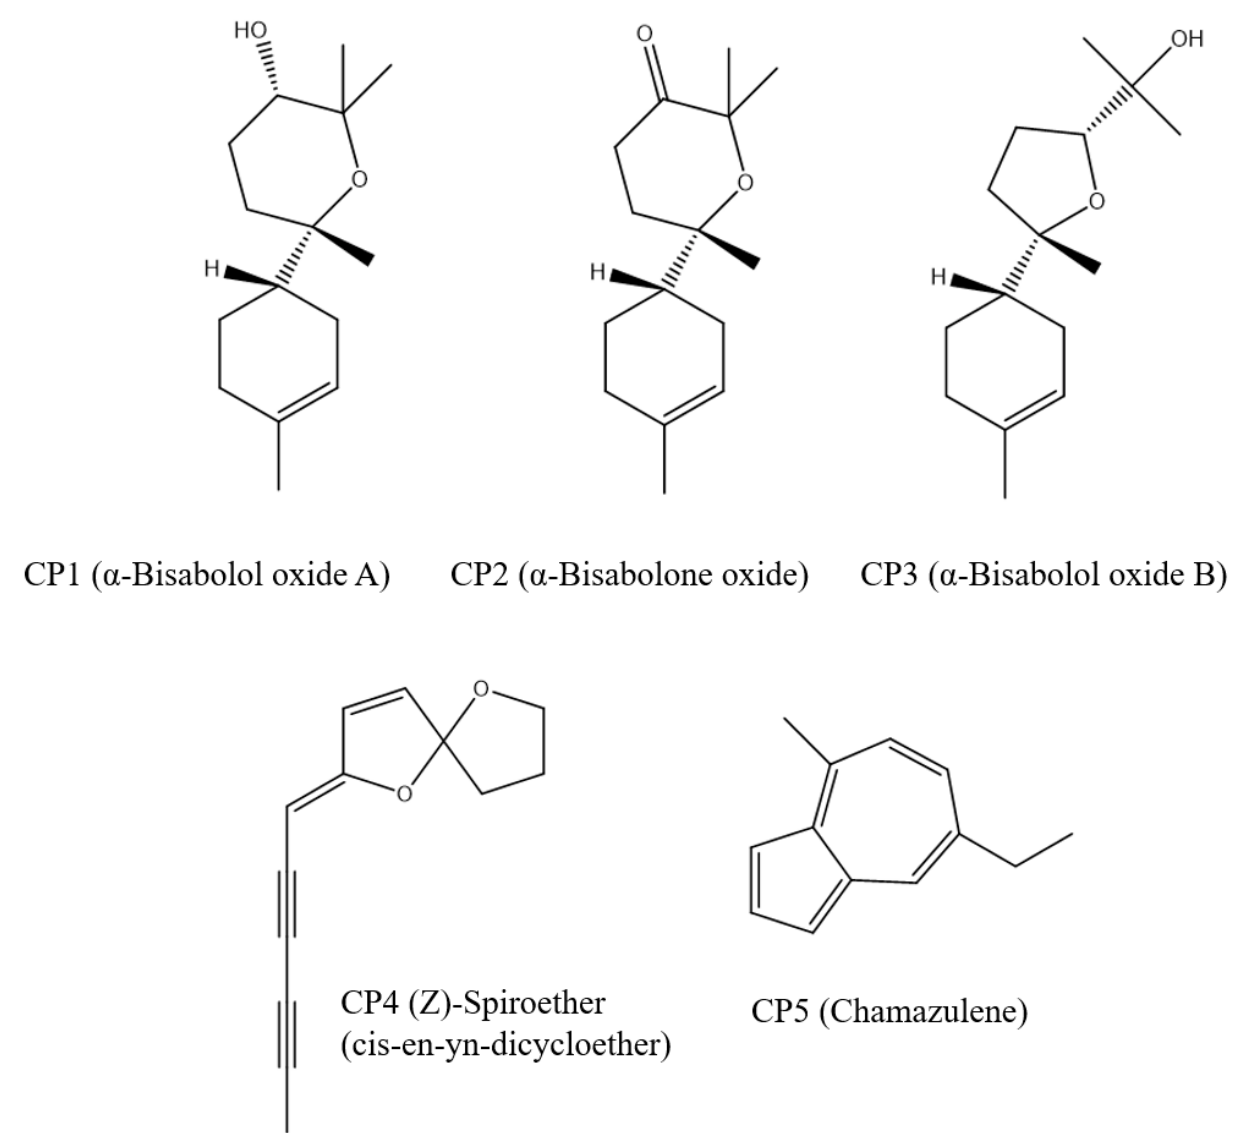
Figure 1. Chemical structures of the most abundant components of the analyzed essential oils.